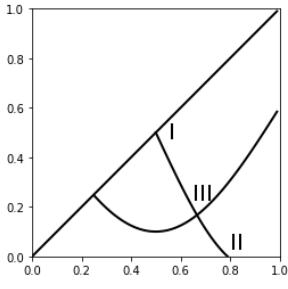
Figure 1. An example of three different intersections of lines of sign change of K